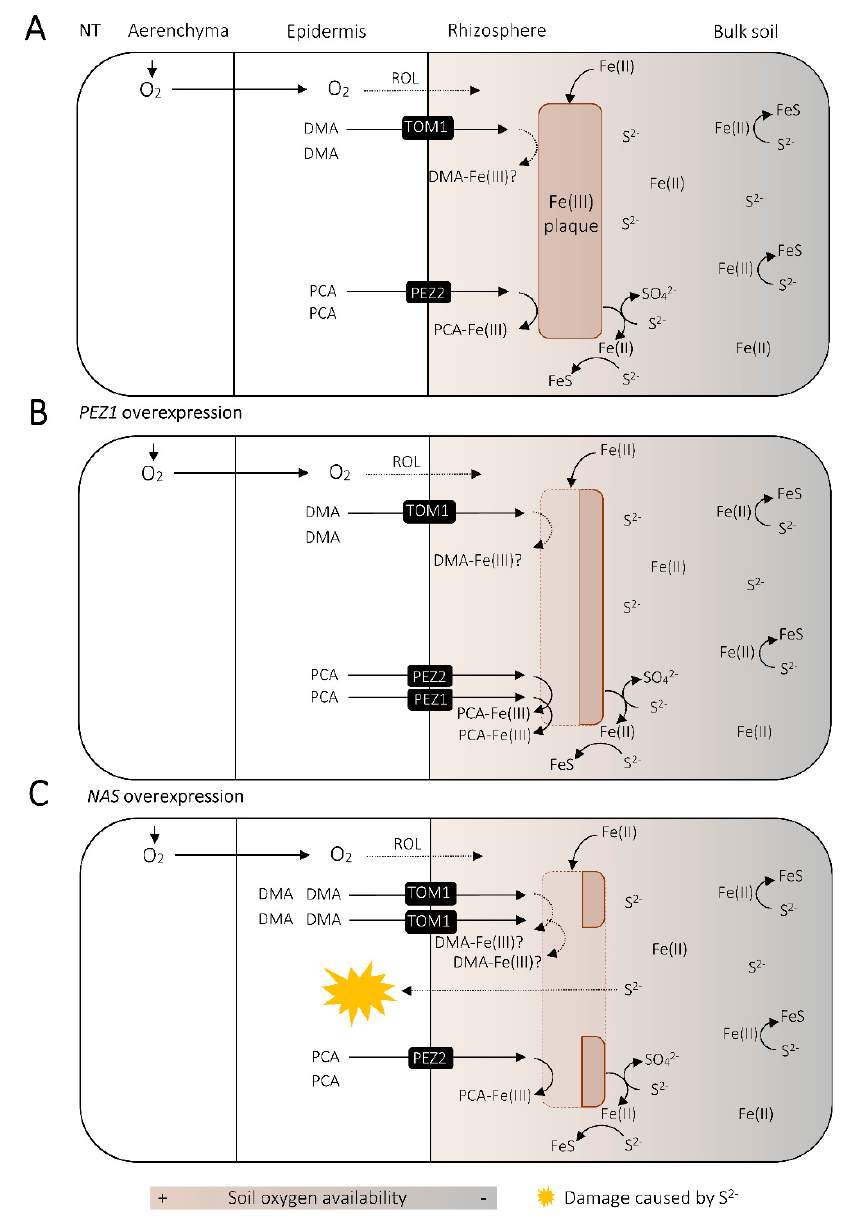
Figure 4. Proposed hypothetical effect of NICOTIANAMINE SYNTHASE ( NAS ) overexpression on Fe plaque accumulation and susceptibility to sulfide toxicity. ( A ) In non-transgenic (NT) rice plants, a portion of the oxygen (O 2 ) supplied for the roots via aerenchyma diffuses to oxidize the rhizosphere (radial oxygen loss; ROL), where iron (Fe) accumulates as ferric oxides as Fe plaque. Protocatechuic acid (PCA) secreted from PHENOLICS EFFLUX ZERO2 (PEZ2) and possibly deoxymugineic acid (DMA) secreted from TRANSPORTER OF MUGENEIC ACID 1 (TOM1) contribute to solubilization of Fe plaque. Sulfide (S 2- ) can also react with Fe to form FeS. ( B ) PEZ1 -overexpressing plants reported by Ishimaru et al. (2011) accumulated less Fe on their roots. This was likely due to increased secretion of phenolics to the rhizosphere through PEZ1. ( C ) NAS overexpression leads to increased DMA synthesis as well as upregulation of TOM1 , leading to enhanced secretion of DMA into the rhizosphere. If DMA contributes to Fe plaque solubilization and forms stronger complex with Fe(III) than phenolics do, NAS overexpression might result in significant reduction of Fe plaque. This might have implications for buffering sulfide toxicity; however, this needs further research.